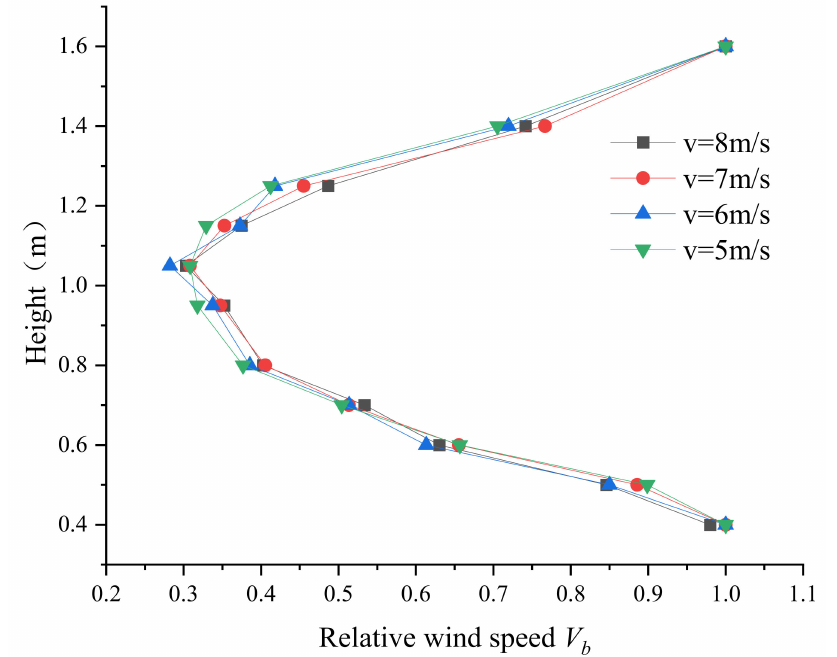
Figure 10. Variation of relative wind speed with height at 0.1 m downwind of canopy of experimental tree